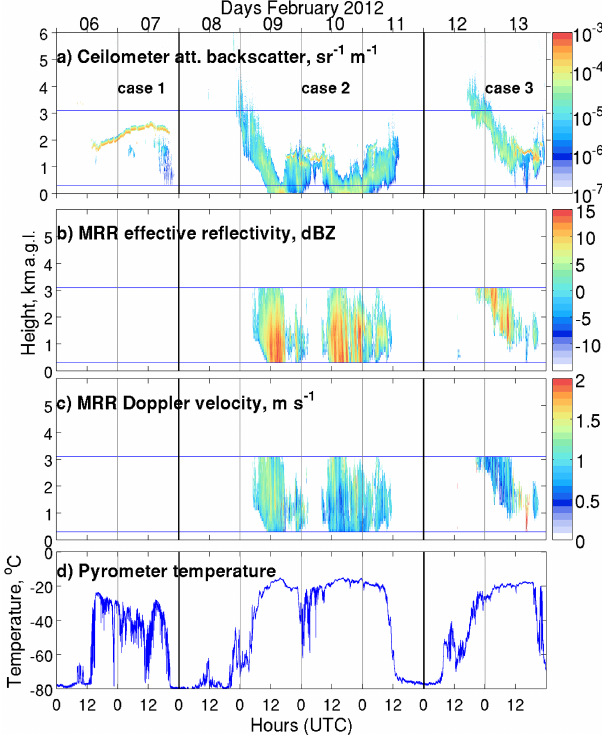
Figure 4. Hourly meteorological parameters during the case studies period 6–13 February 2012: (a) incoming long-wave (LW) and net short-wave (SW) fluxes, (b) wind speed (WS), wind direction (indi- cated by “hockey sticks”), and local pressure ( P ), (c) near-surface air temperature ( T ) and relative humidity with respect to ice (RH i ), and (d) snow height relative to 1 January 2012,